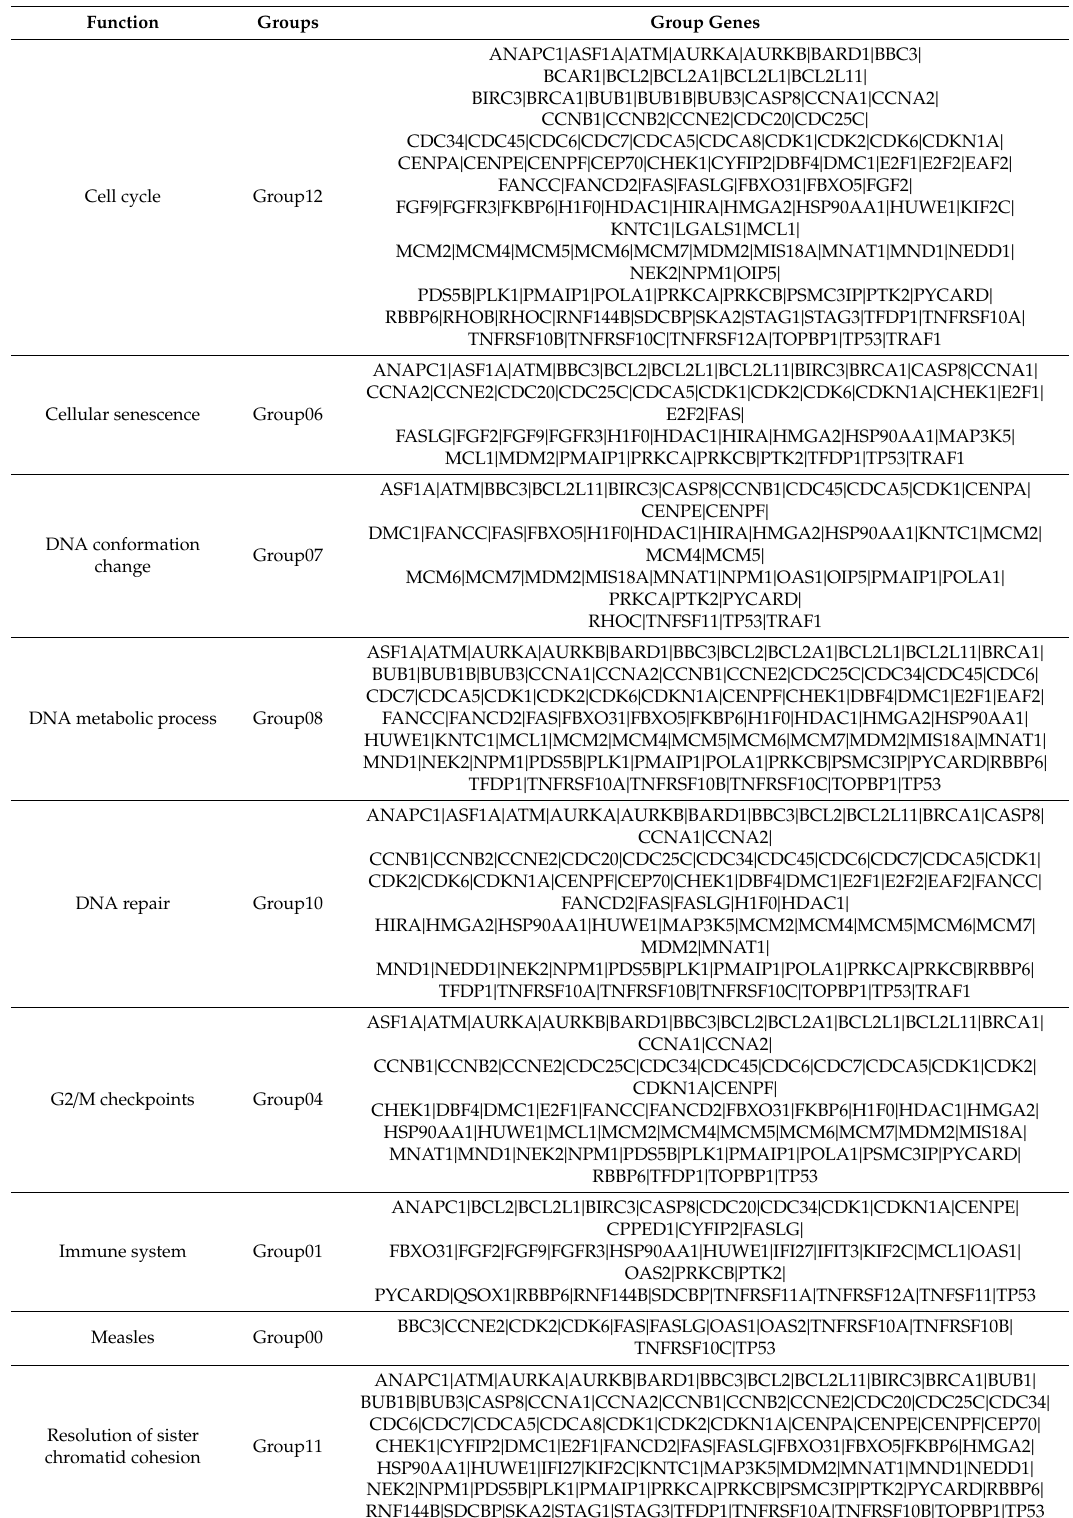
Table 3. Pathway enrichment of the modulated seed proteins using